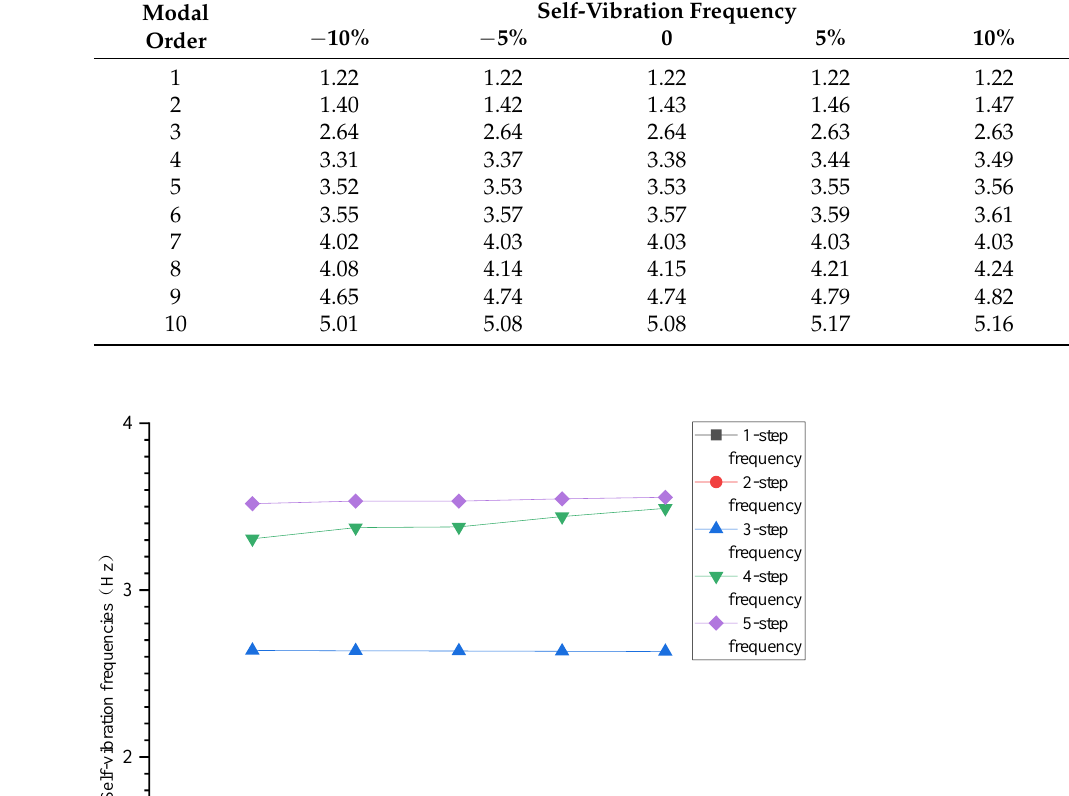
Table 5. Self-vibration frequencies (Hz) for different main beam stiffnesses of Structure I. Modal